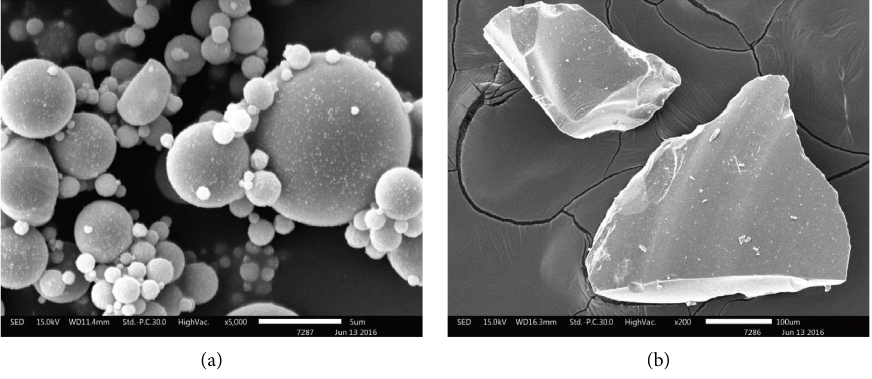
Figure 2: SEM images of (a) FA and (b)